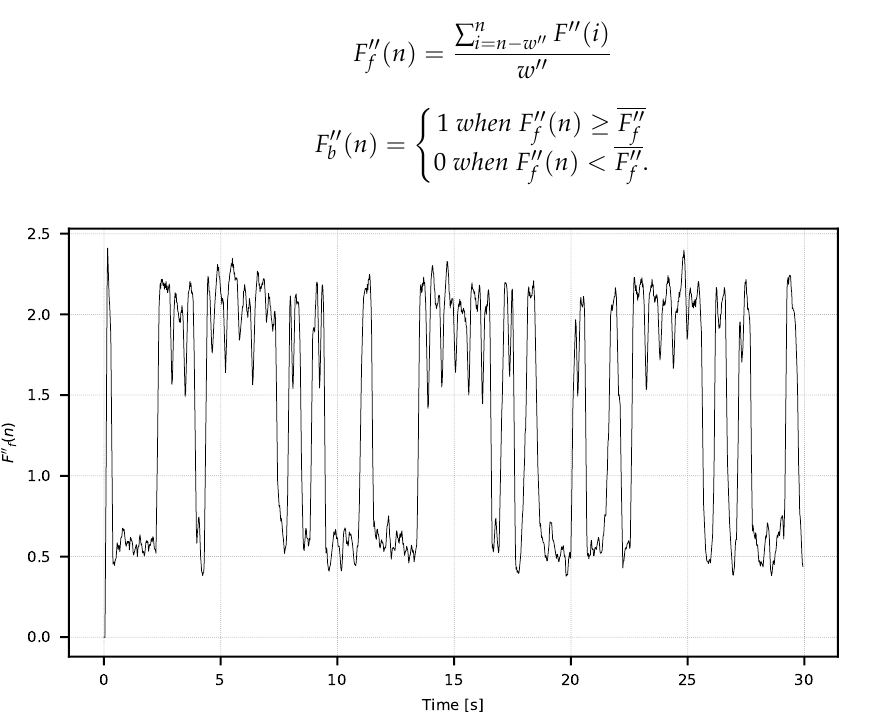
Figure 12. Signal F (cid:48)(cid:48)